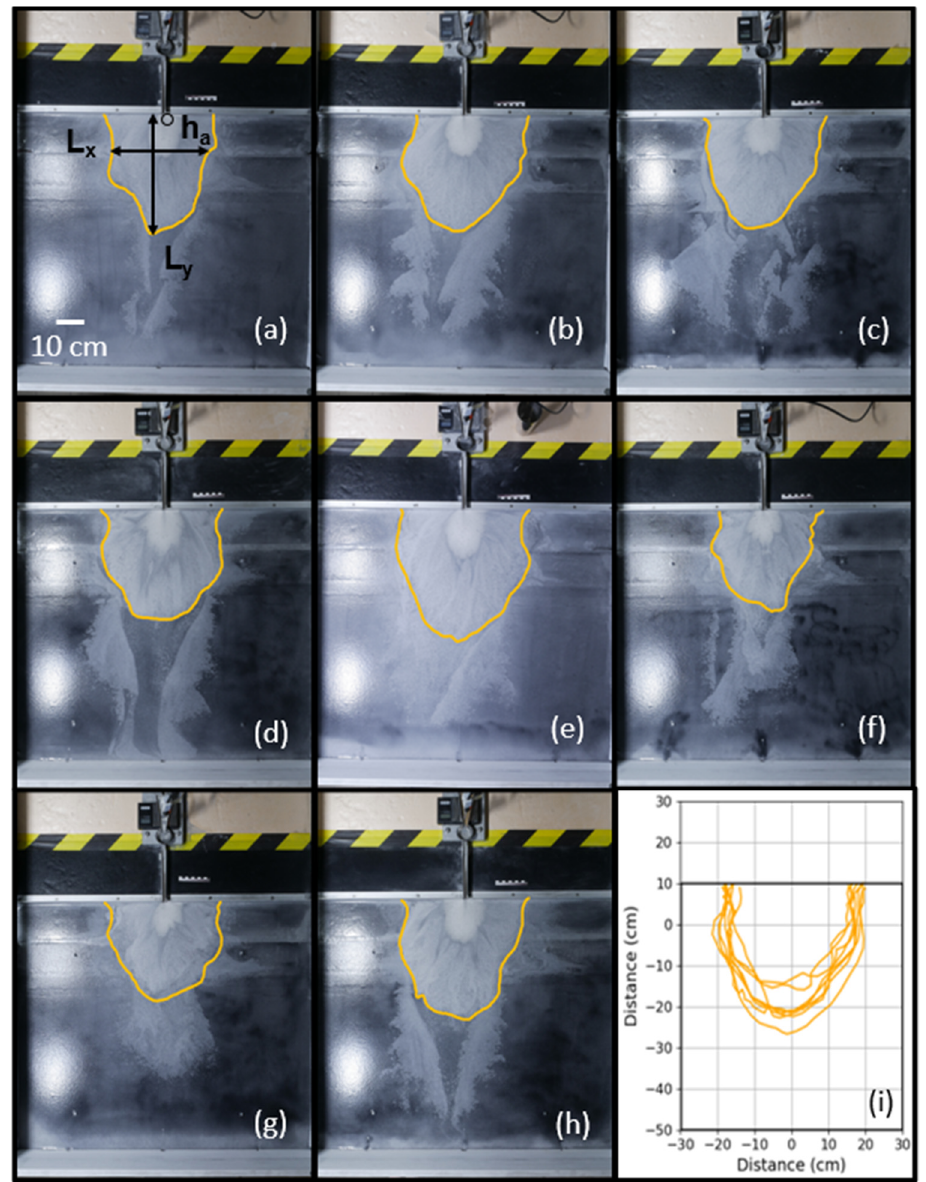
Figure 3. Experimental alluvial fan geometry obtained after the 1-hour first modeling phase without tectonics. ( a – h ) Top-view pictures of alluvial fans for each experiment. The alluvial fan boundary is orange. L x is for width, L y is for length, and h a for apex height. ( i ) Alluvial fans geometry of all analog experiments. The coordinate system is centered in the middle of the fault. Orange lines give the fan boundaries’ locations. The black box represents the deposition area.